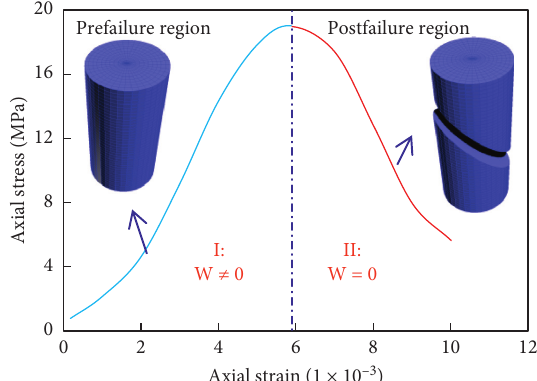
Figure 7: The complete stress-strain curve of the coal